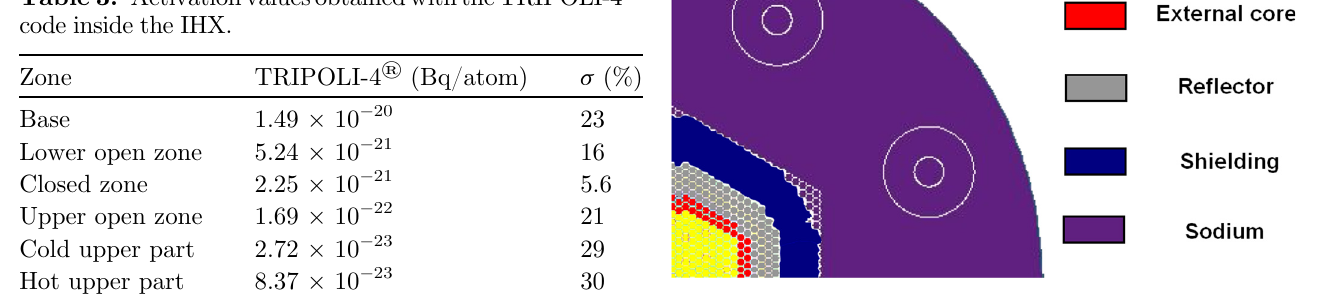
Fig. 26. Radial description of the core and the IHX.